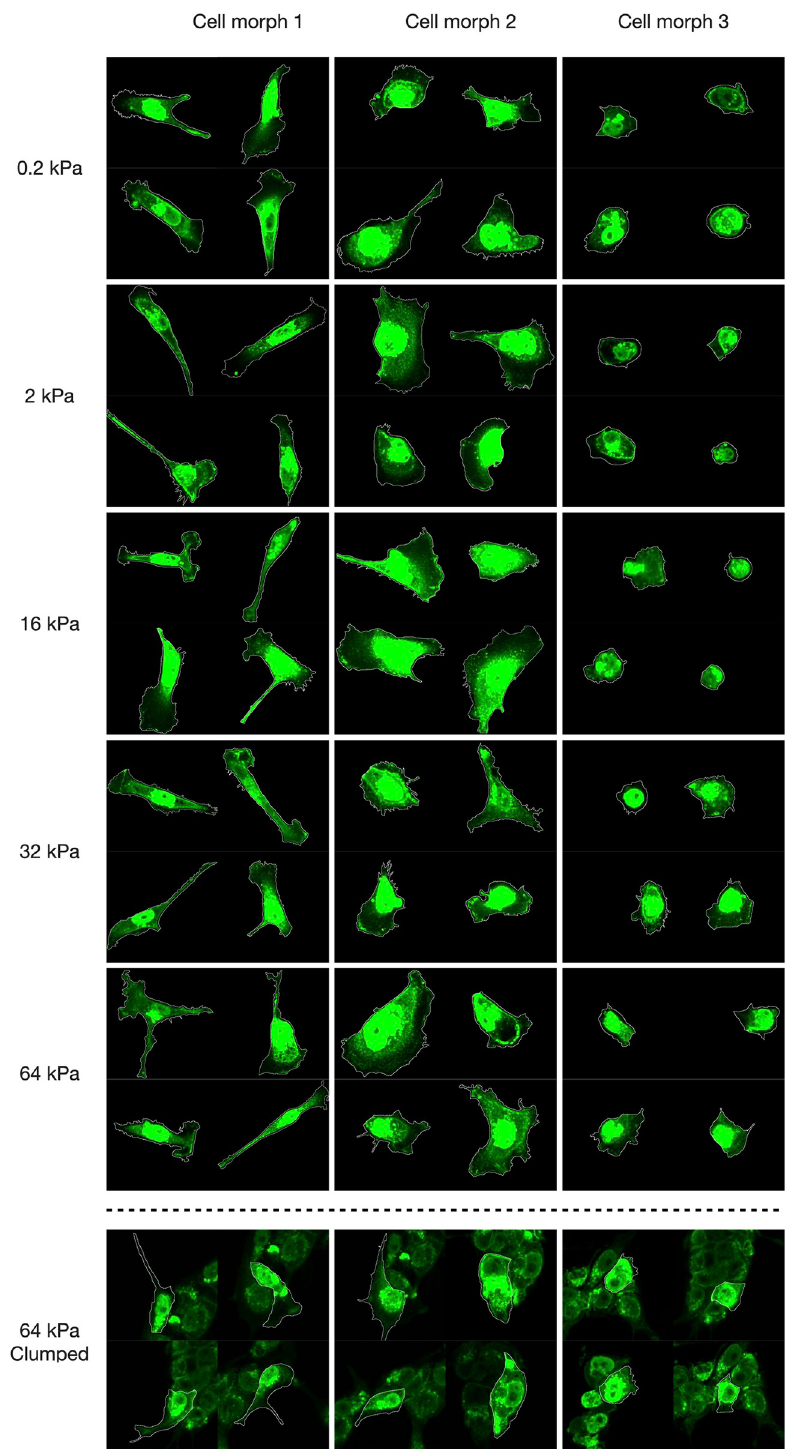
Fig 5. Visualisation of cell morphs. Representative images of cells cultured at different stiffness levels corresponding to the three cell morphs, as determined by the clustering algorithm. The bottom row provides examples of Clumped cells classified as one of the three cell morphs by the RF classifier. Cell membranes were visualised using WGA staining.